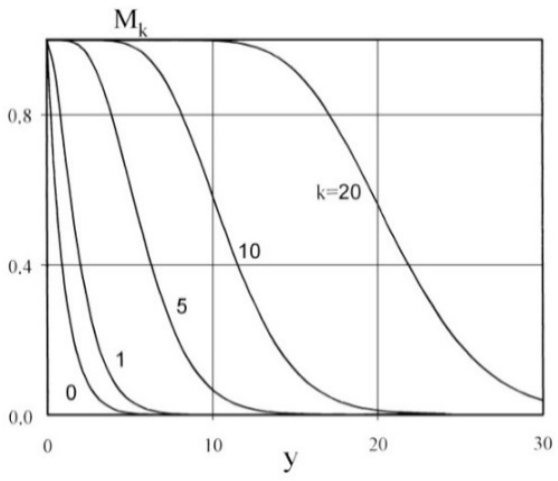
Fig. 2. Fractions M k (y) of electrons with energy ε ≥ ε -k W .